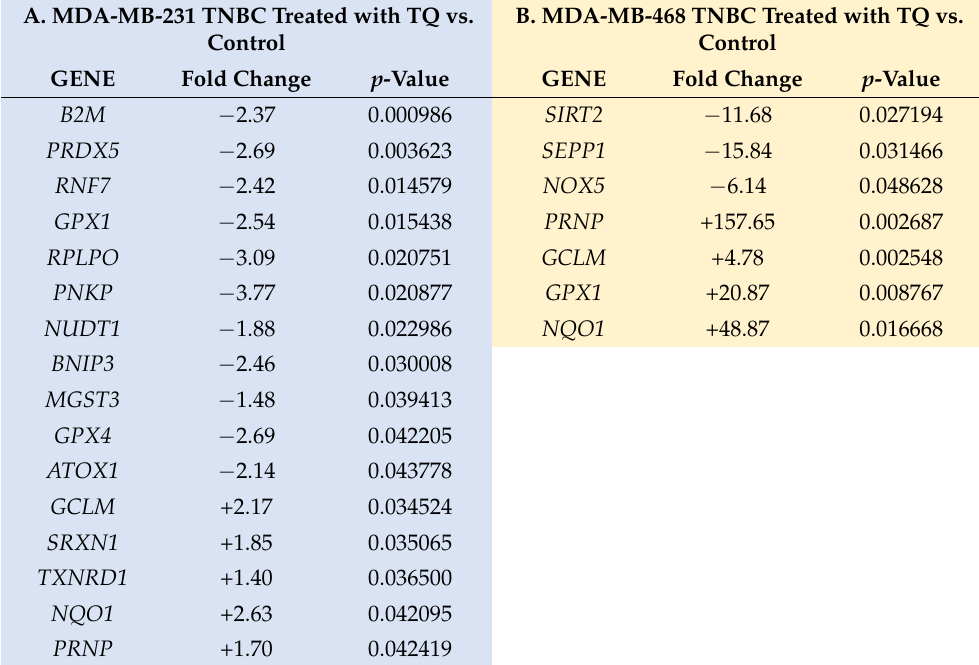
Table 1. A comparative illustration of TQ effects on mRNA oxidative stress-antioxidant defense gene expression in MDA-MB-231 and MDA-MB-468 TNBC cells following a 24 h exposure